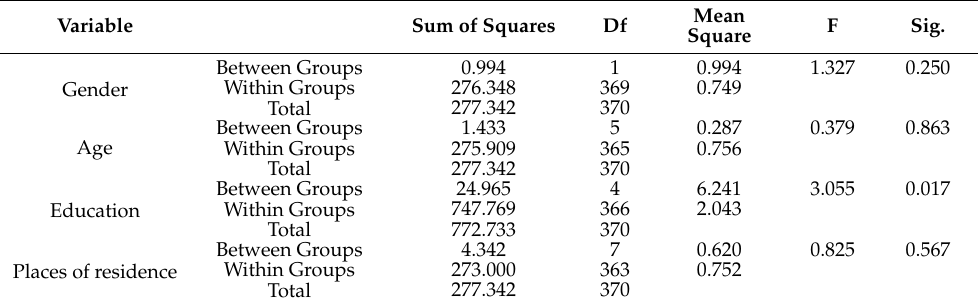
Mean Square F Sig.